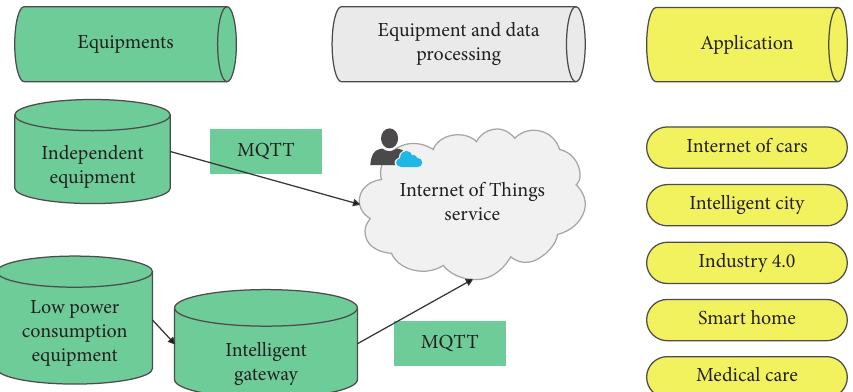
Figure 9: Application of MQTT in the internet of things.